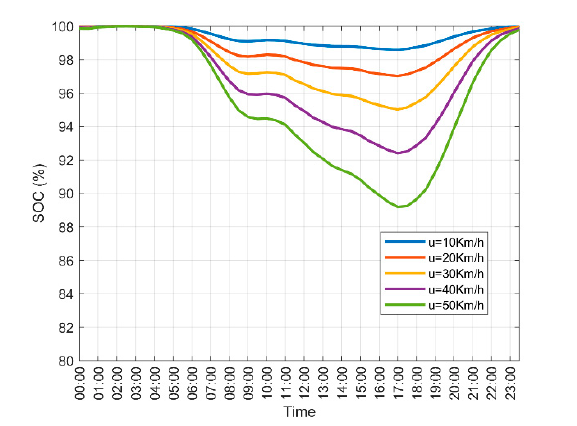
Figure 3. Average state of charge (SoC) level when Scenario 1 is considered for the charging